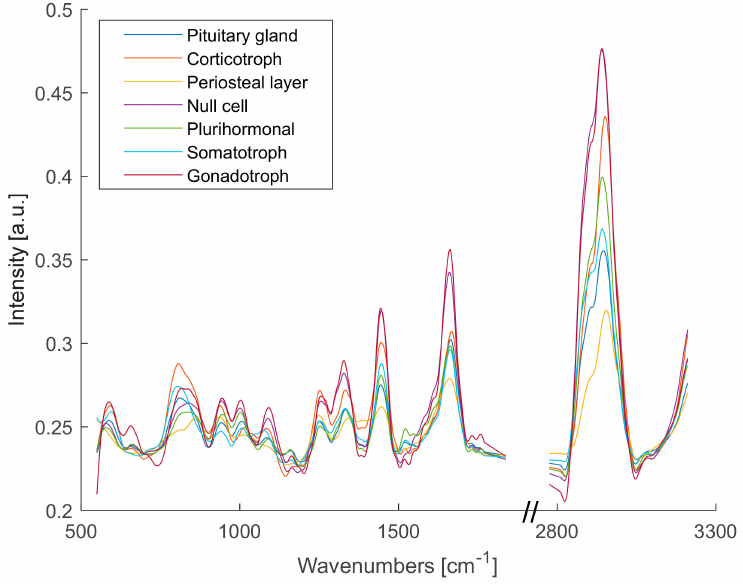
Figure 1. Medians of Raman spectra of pituitary gland tissue, adenoma subtypes (corticotroph, null cell, plurihormonal, somatotroph, gonadotroph) and periosteal